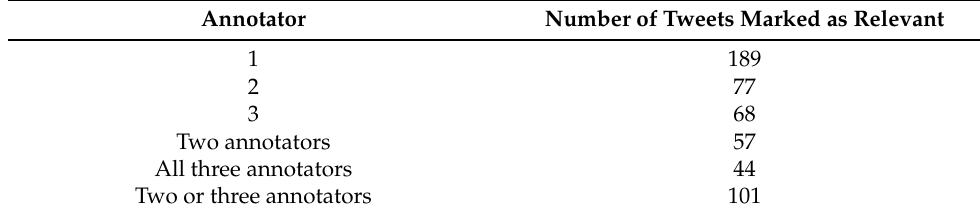
Table 3. Results of